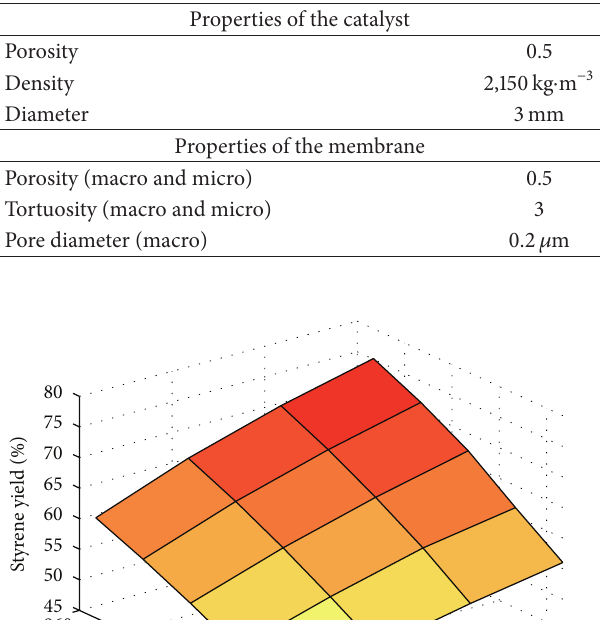
Table 2: Properties of the catalyst and membrane.